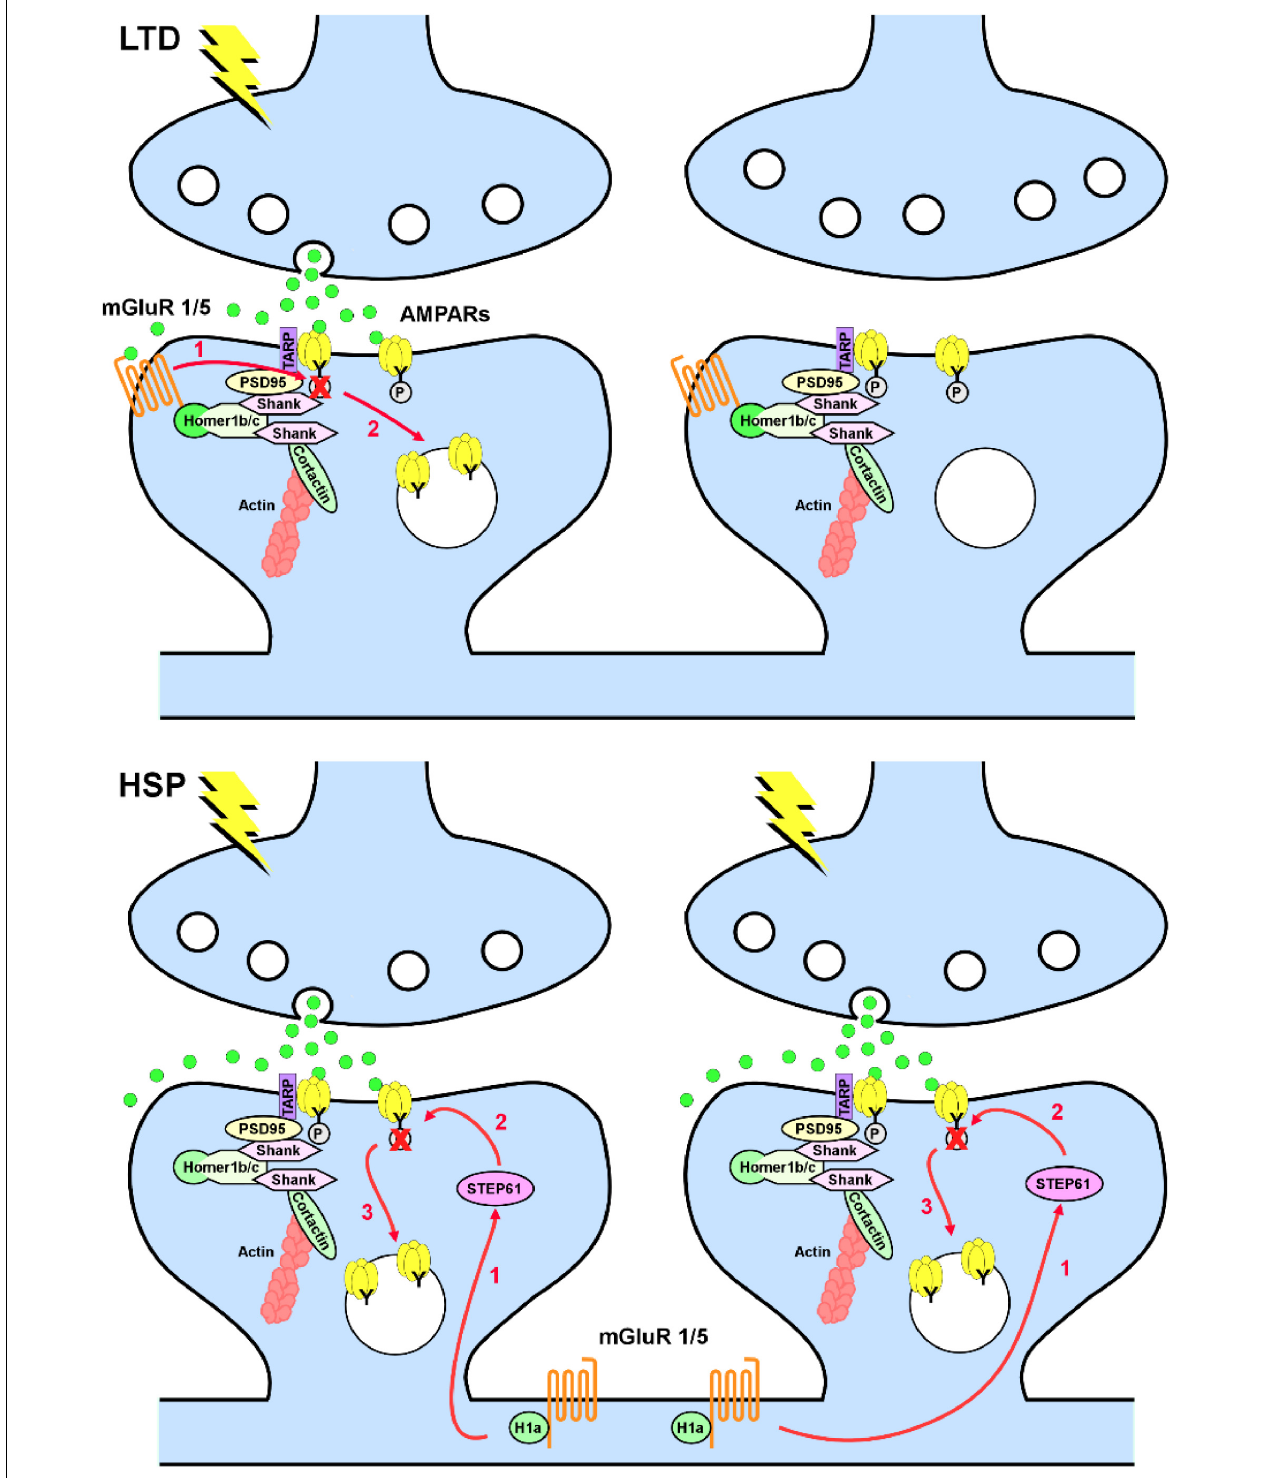
FIGURE 1 | Metabotropic glutamate receptors 1/5 (mGluR1/5) in long-term depression (LTD) and homeostatic synaptic plasticity (HSP). Top, in LTD, mGluR1/5 are anchored at perisynaptic sites via Homer 1b/c and activated in a synapse-specific manner by synaptically released glutamate. Activation of mGluR1/5 leads to tyrosine dephosphorylation of the GluA2 subunit of AMPARs (1), with consequent increase in AMPAR endocytosis (2). Bottom, in HSP induced by chronic increase in network activity, induction of Homer1a decouples mGluR1/5 from the synaptic signaling machinery and induce a constitutive glutamate-independent activation of mGluR1/5. Homer1a-induced mGluR1/5 signaling requires upregulation of the striatal-enriched protein tyrosine phosphatase (STEP61; 1), with consequent dephosphorylation of the GluA2 subunit of AMPARs (2) and increase in AMPAR endocytosis (3) in a non-synapse-specific manner.